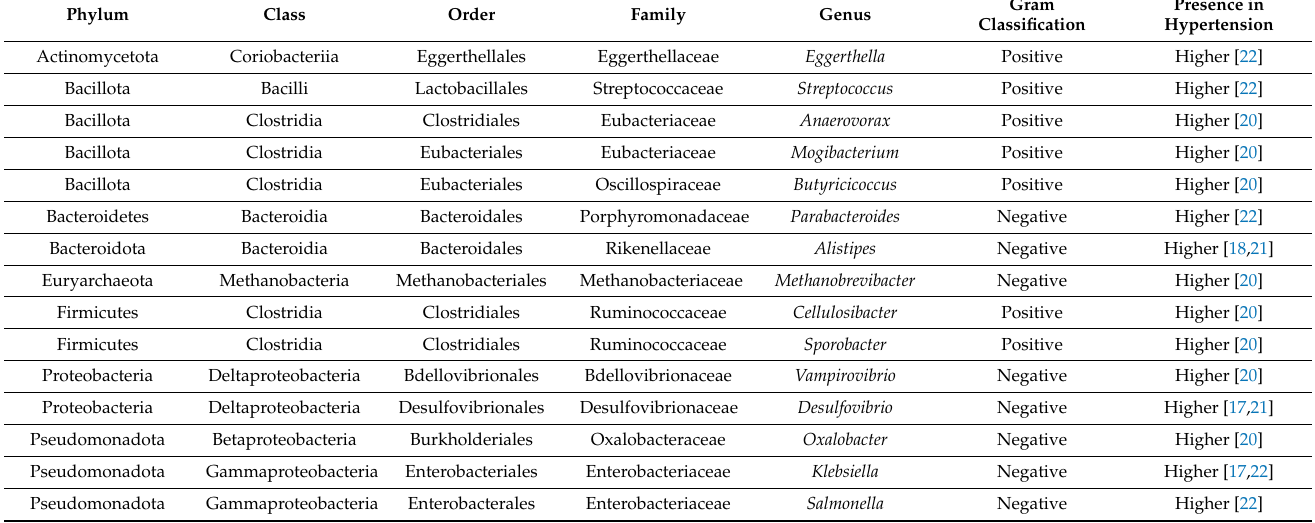
Table 1. Presentation of the bacteria population representing a higher capacity in individuals with hypertension or lower capacity in people with normal blood pressure. The table contains the distribution for phylum, class, order, family, genus and gram